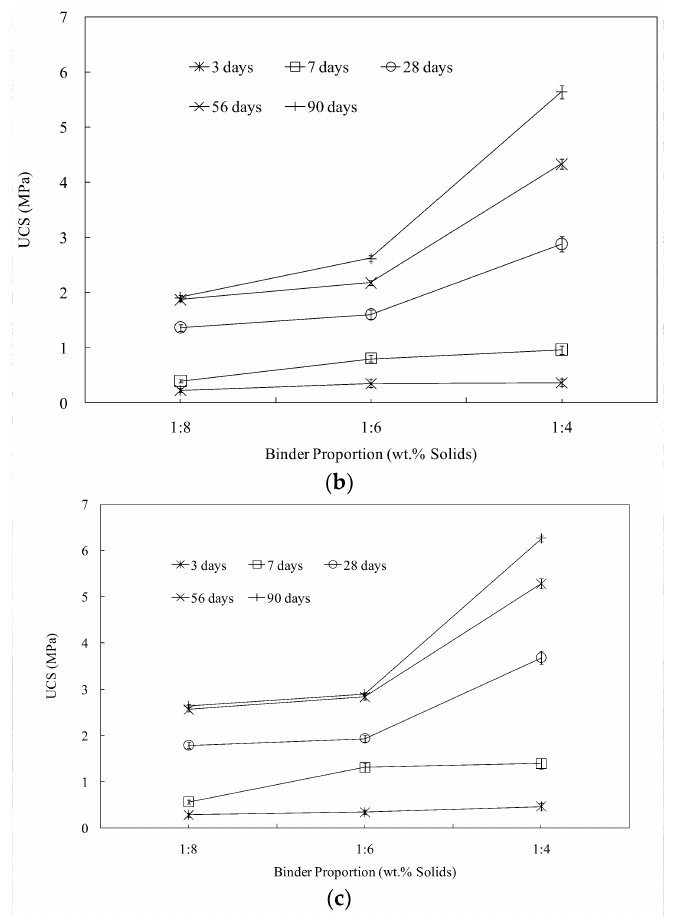
Figure 4. The effects of different binder contents on the UCS of CTB samples. ( a ) 65 wt %; ( b ) 68 wt %; ( c ) 70 wt